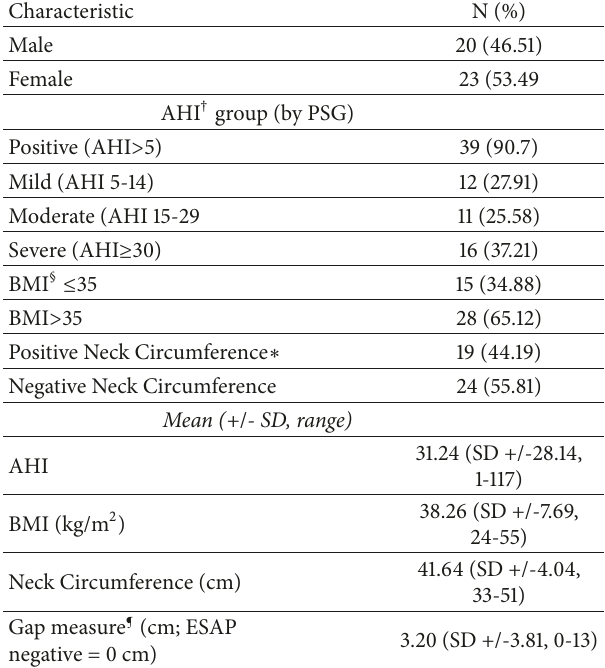
Table 1: Patient demographics and